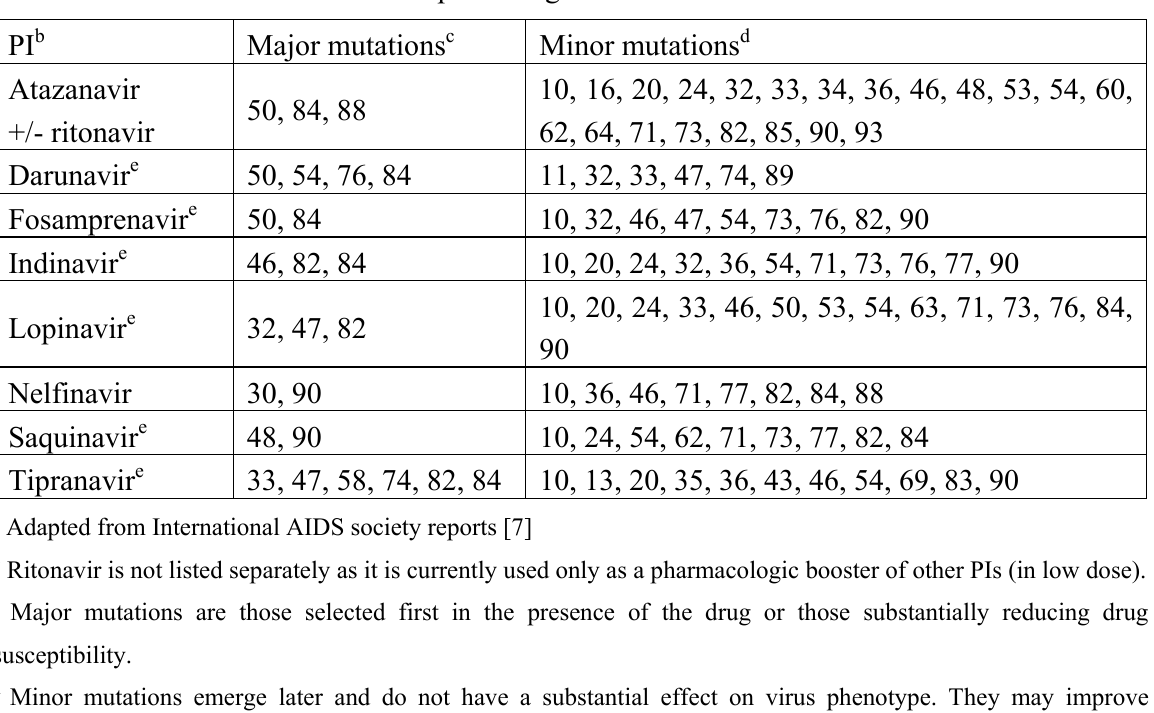
Table 1. Mutations in the protease gene associated with resistance to PIs a